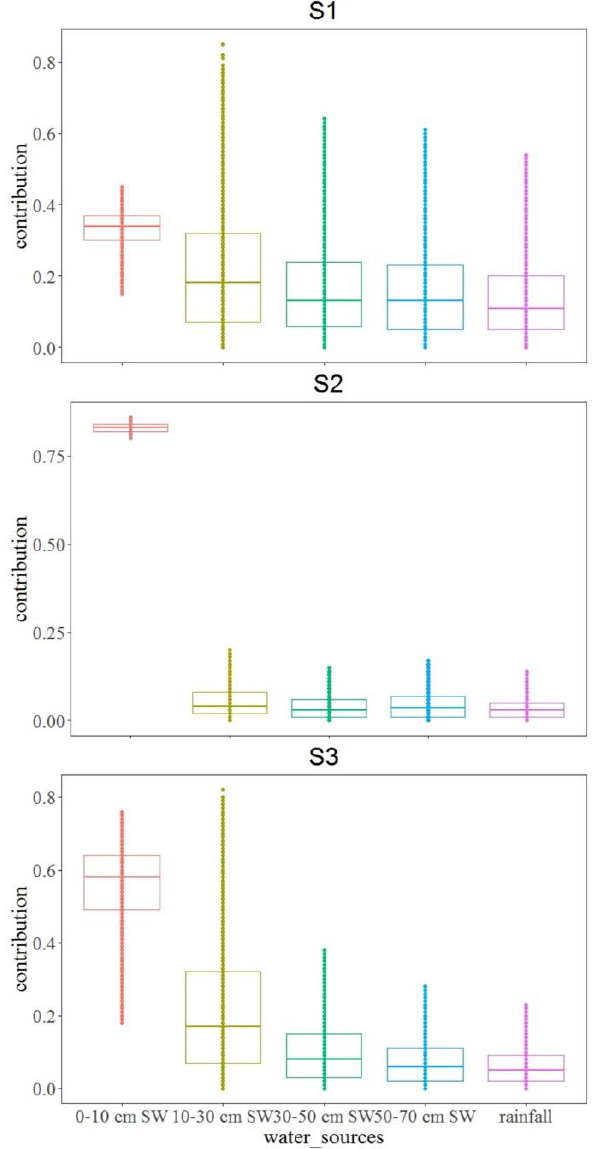
Figure 4. Boxplots of source water relative uptake (estimated by IsoSource) in the 3 locations and with the 5 sources.